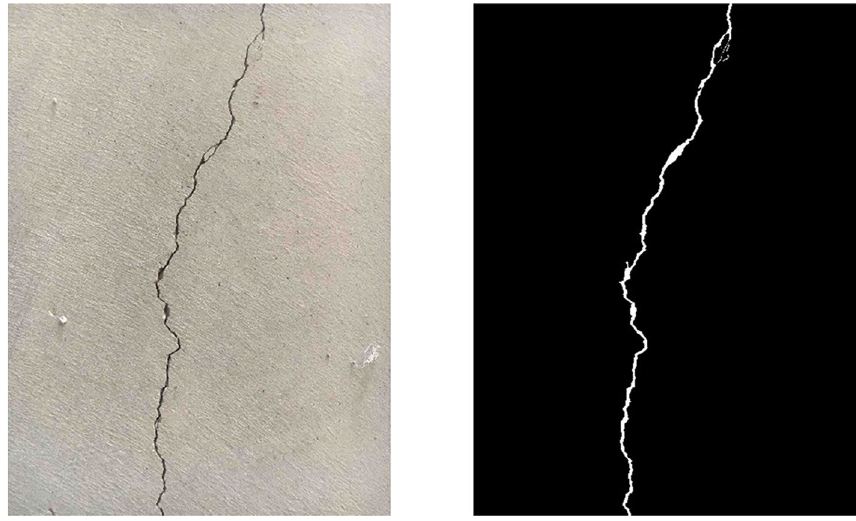
Figure 1. Sample picture of cracked concrete pavement along with its alpha map obtained from the dataset by Özgenel